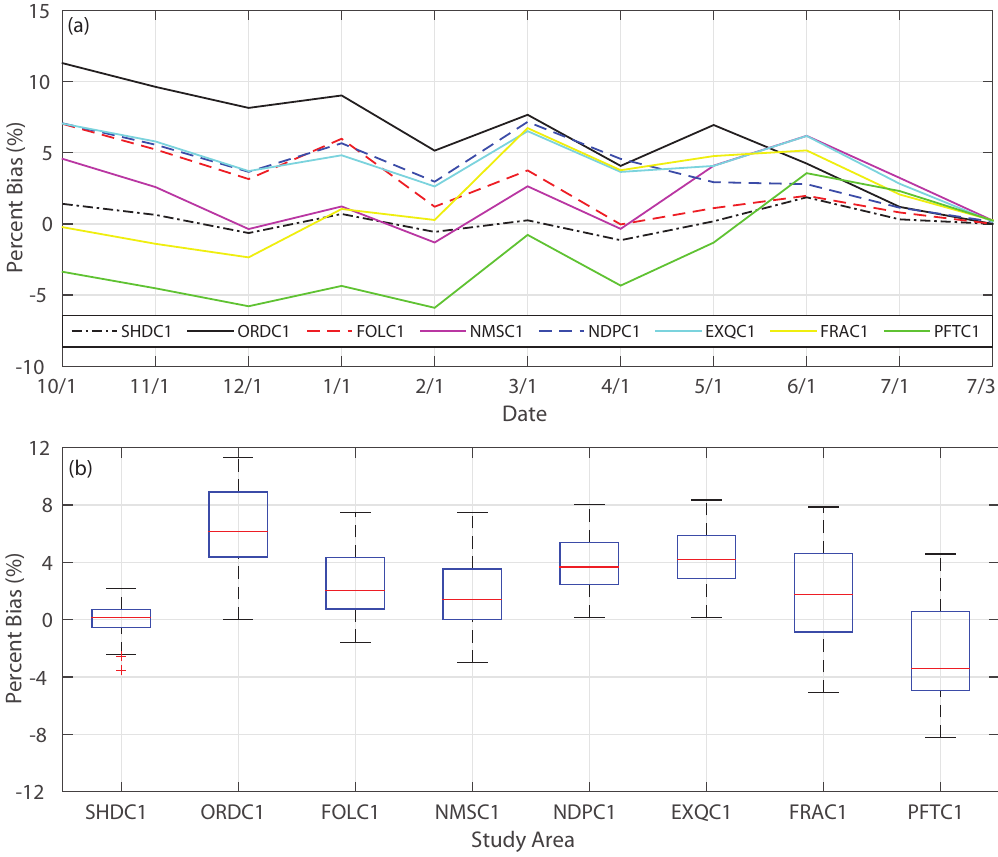
Figure 7. ( a ) Percent bias of mean forecasts at the monthly scale and ( b ) boxplot of percent bias of mean forecasts on the daily scale from 1 October to 31 July. The description of boxplot features is provided in Figure 4’s